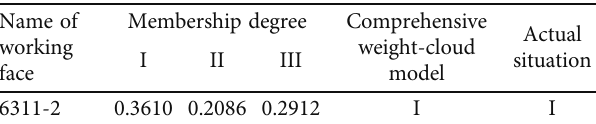
Table 6: Membership degree of working face belonging to each risk